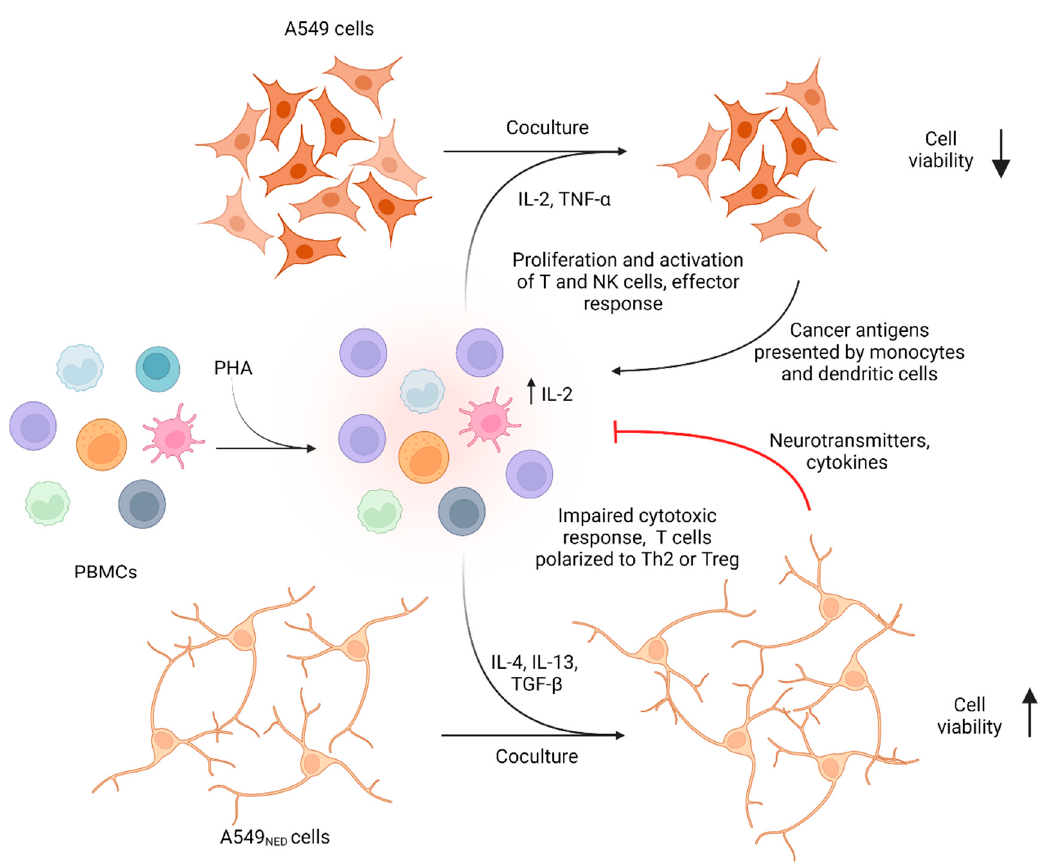
Figure 7. Cellular mechanisms involved in cocultures. We illustrate the mechanisms proposed to explain our results, in which A549 cells lost viability in coculture with PHA-preactivated PBMCs, while A549 NED cells had higher viability. Our results suggest that the pre-activation of cells with PHA caused the production of IL-2, a cytokine necessary for the activation of NK cells and monocytes, which exerted their effector functions on A549 cells, producing more proinflammatory cytokines; apoptosis favored the presentation of antigens mediated by monocytes and dendritic cells, allowing the activation and clonal expansion of cytotoxic T lymphocytes, which also exerted their cytolytic activity. A549 NED cells, possibly through neurotransmitters such as serotonin and norepi ‐ nephrine and cytokines such as IL ‐ 4, caused the polarization of T cells towards Th2 and Treg, inhib ‐ iting cytotoxic activity and secreting cytokines that favor proliferation from cancer cells, such as IL ‐ 4, IL ‐ 13, and TGF ‐β [21,52,57,60–62]. Image created on BioRender.com, licensed and published un ‐ der agreement MH24DCXFXU.